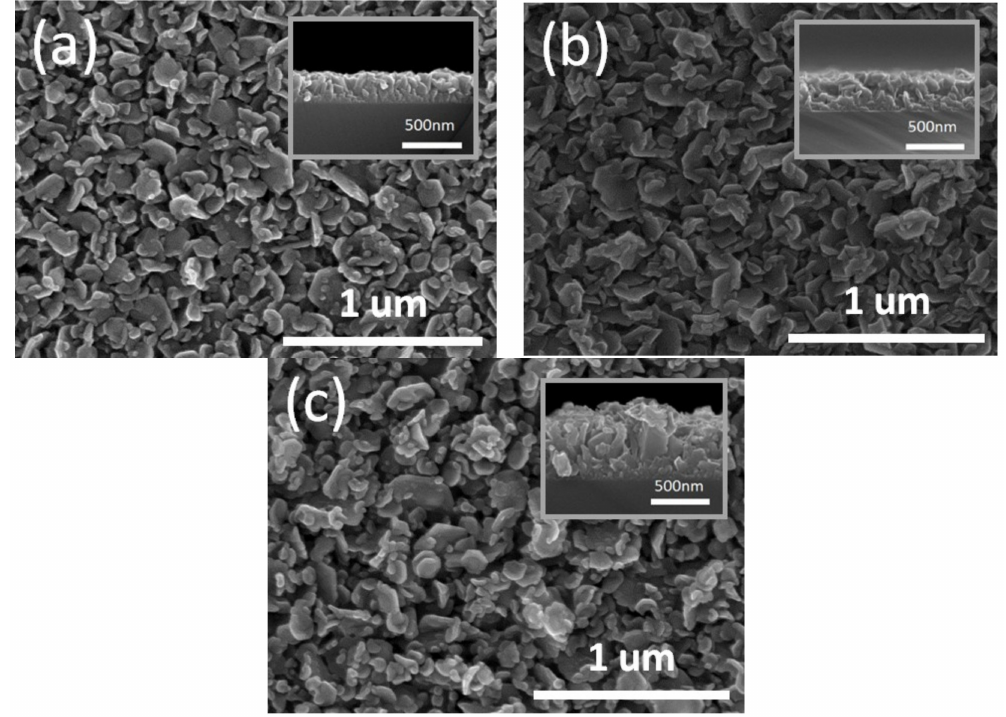
Figure 1. SEM images of the sample surface ( a ) ST1; ( b ) ST2; and ( c ) ST3. The cross-section is shown in the